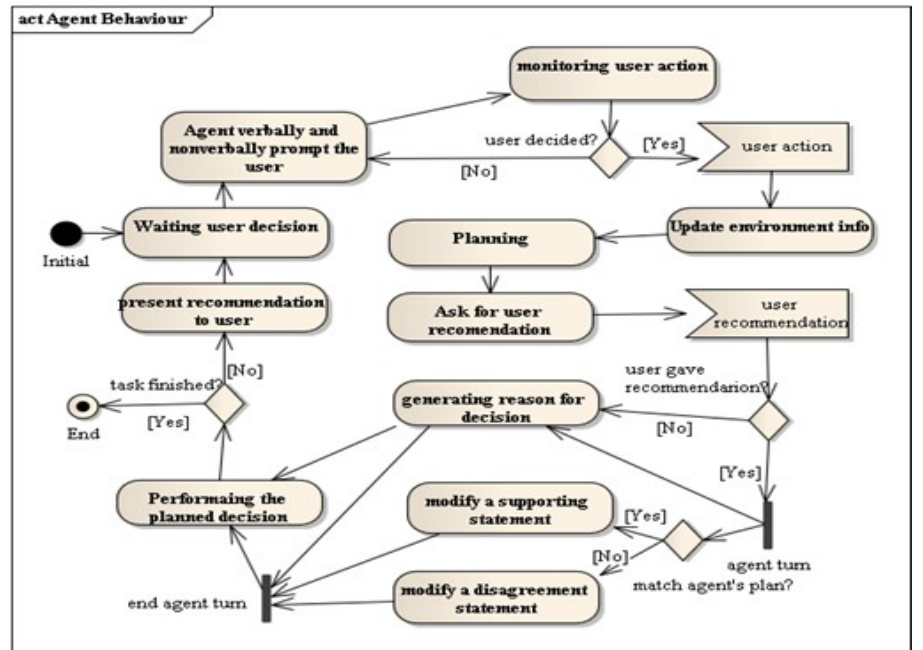
Figure 5. Activity diagram of agent’s behaviour.